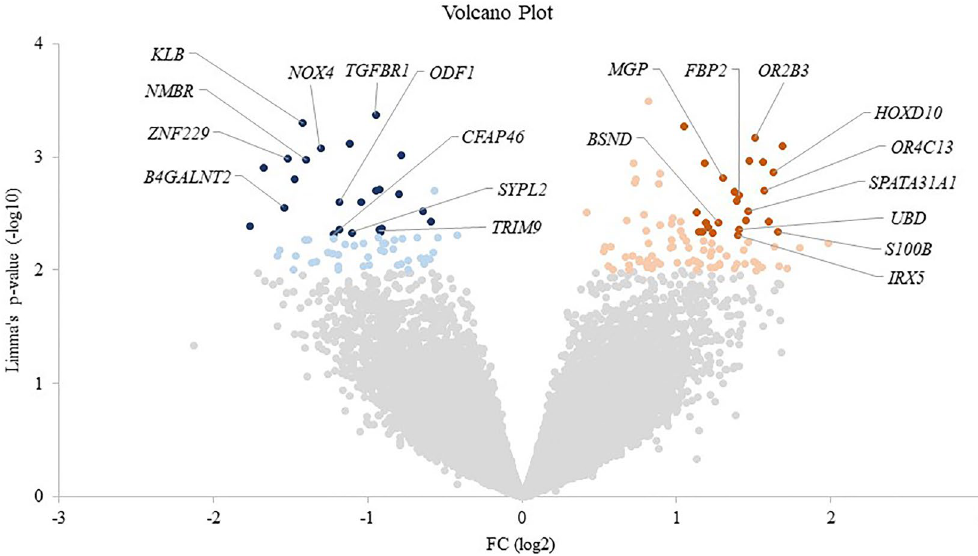
Figure 3. Volcano Plot for all probes included in PBC microarray analysis after background correction, normalization and merging of the replicated probes. The negative log10 of Limma’s test p-value for each probe are plotted against the difference (expressed as fold change, FC, log10 value) between children with low vs. high MVPA levels. Genes with p-value < 0.01 with positive FC (up-regulated in low MVPA children vs. high) are represented in orange and with negative FC (down-regulated in low MVPA children vs. high) are in blue. In addition, the 25 up- and down-regulated genes with p-value < 0.005 appear in darker color. The names of the top-10 up- and down-regulated genes with known function are also